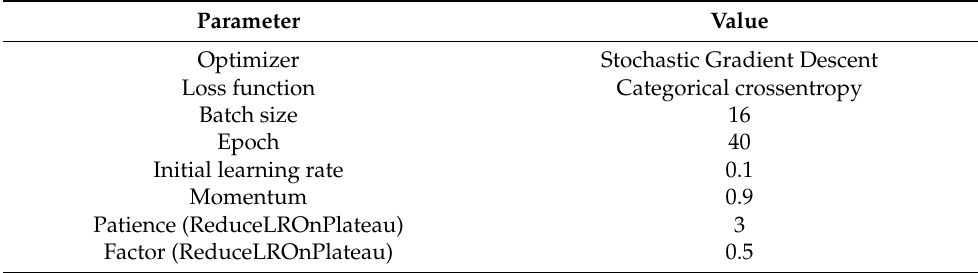
Table 4. Specification of training